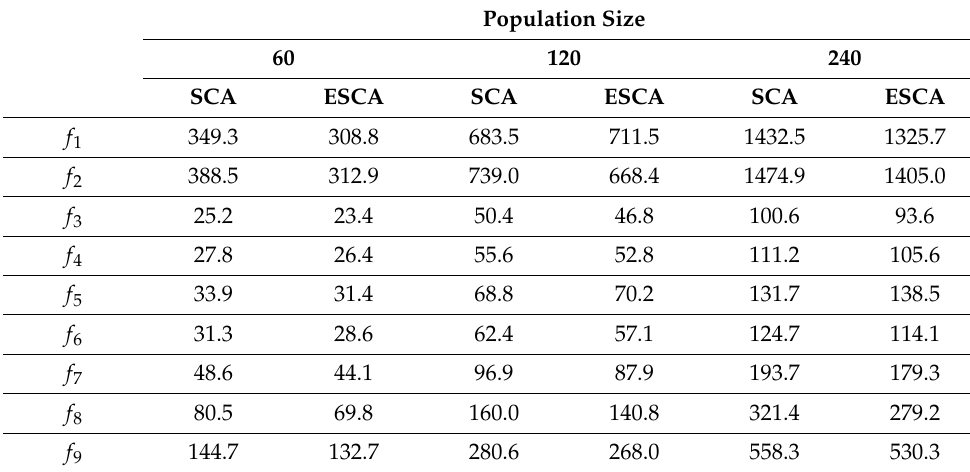
Table 3. Computational times (s.) for sequential SCA and ESCA